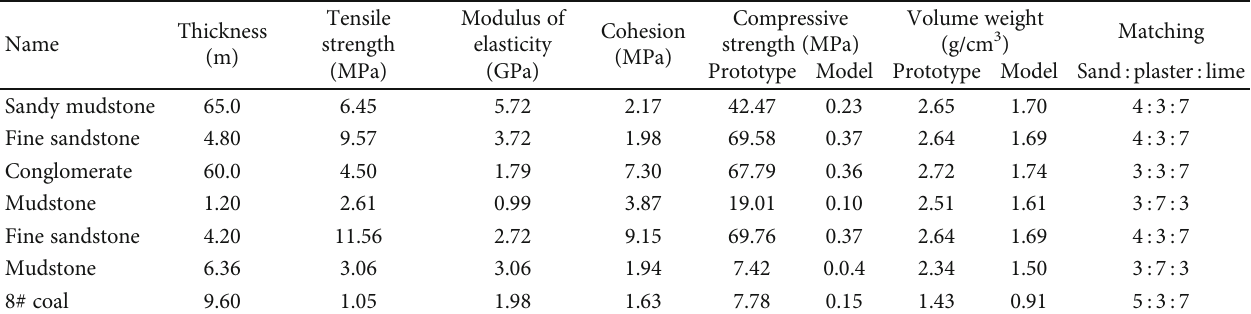
Table 2: Physical mechanical parameters and ratio of coal rock in the